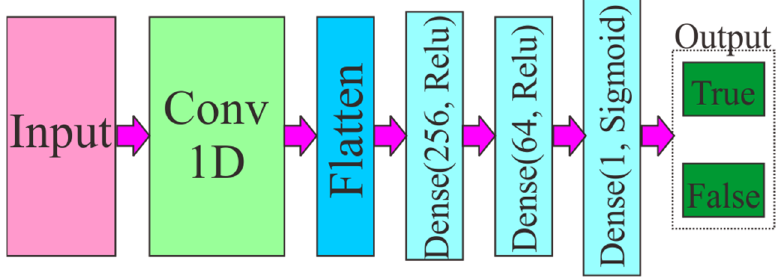
Figure 5. Simple CNN-Based model for binary classification.